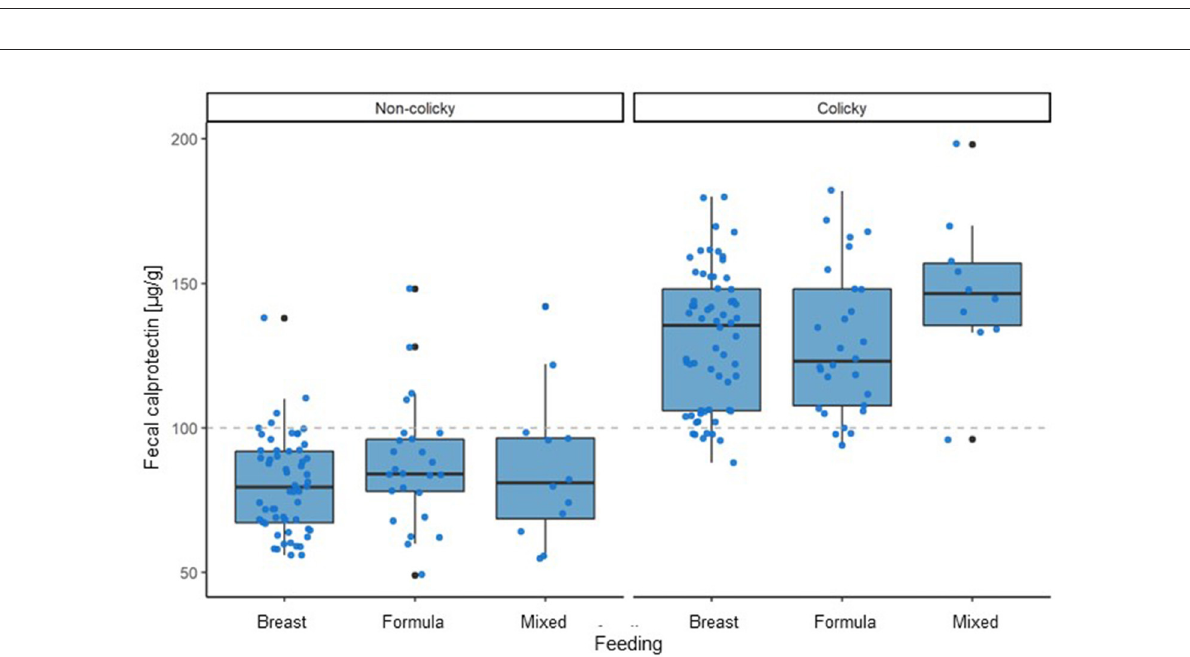
FIGURE4 Influence of type of feeding on fecal calprotectin levels in colicky and non-colicky infants.